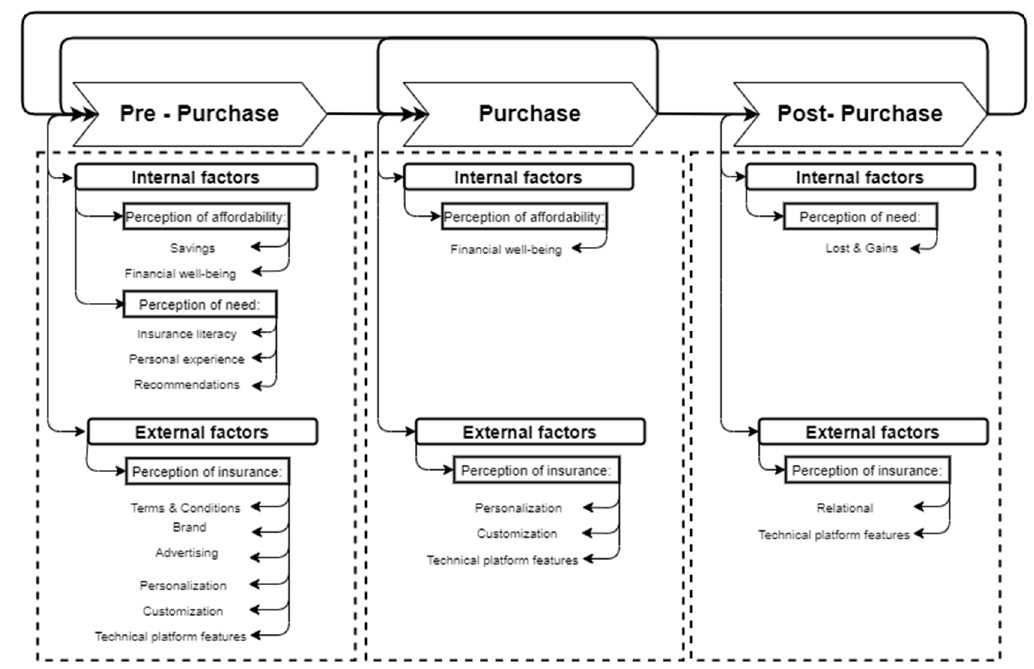
Figure 1. Features and background of the insurance decision-making process. Source: composed by the authors, by following [5,12,13,17] .